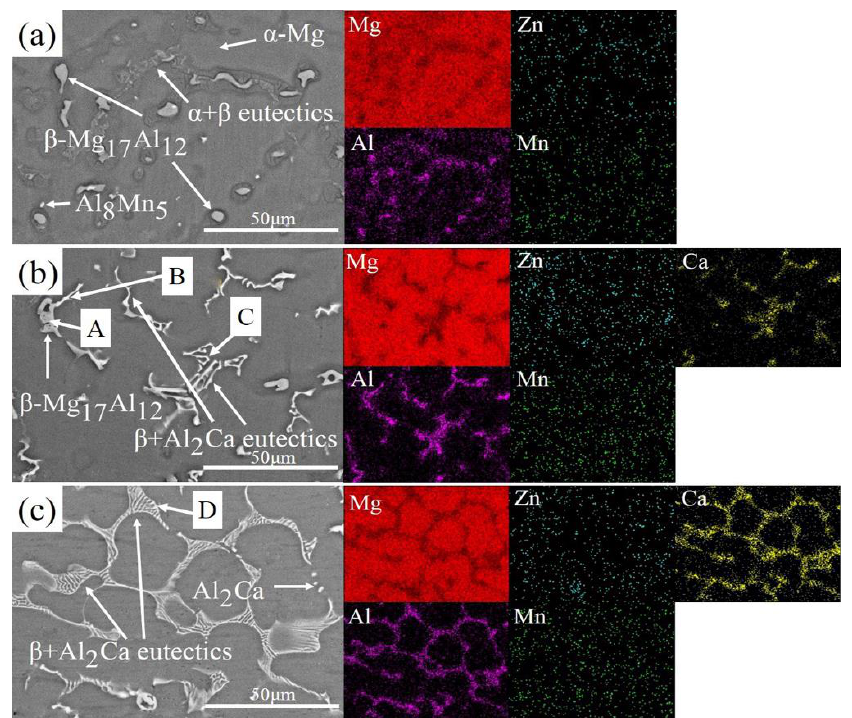
Figure 3. Microstructures of as-cast ( a ) AZ80, ( b ) AZX801 and ( c ) AZX802 alloys. The microstructures of as-cast alloys are quitely different.